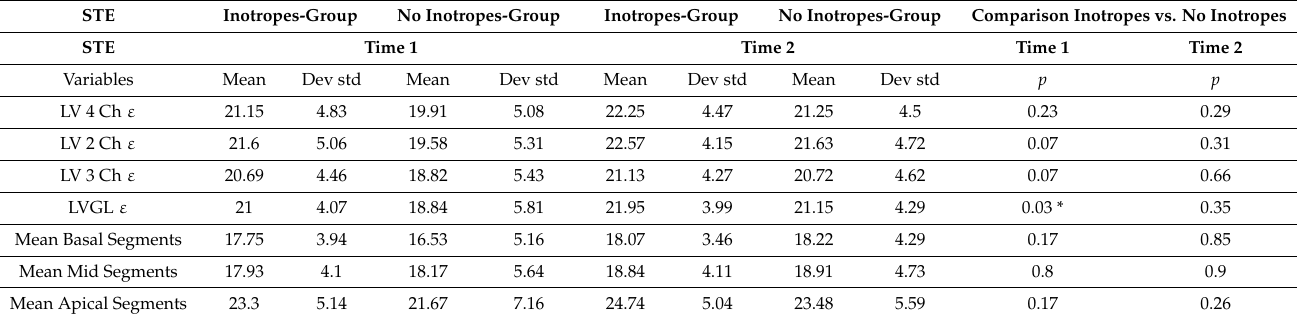
Table A4. Differences in LV ε values among patients whose were administered inotropes and patients whose did not.